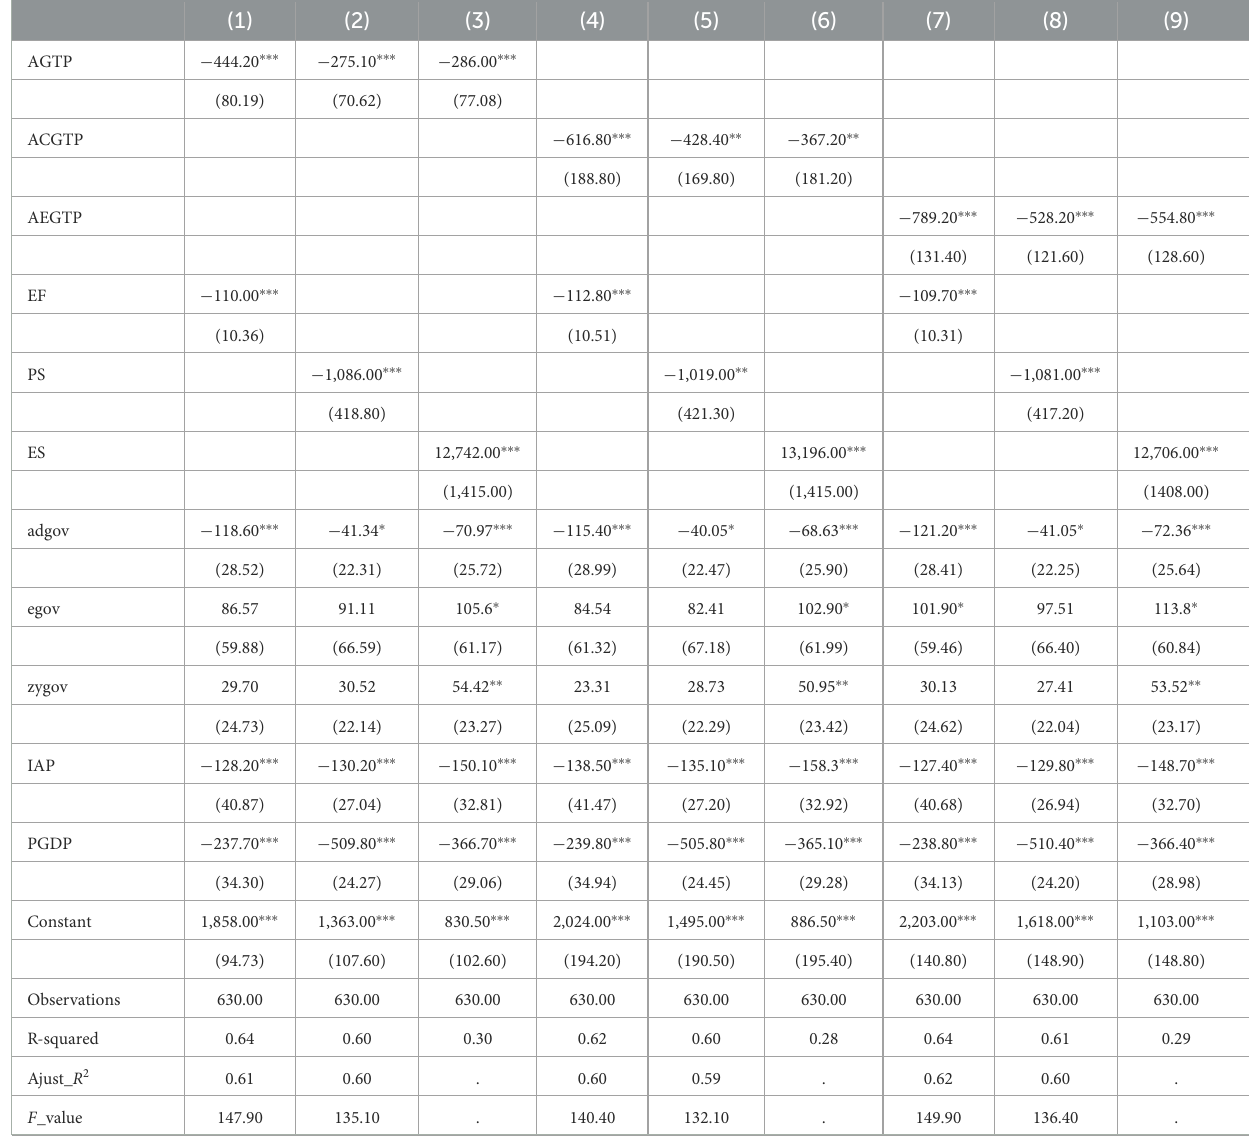
TABLE 3 Empirical outcomes of the influence of GTA and intermediary variables on carbon release